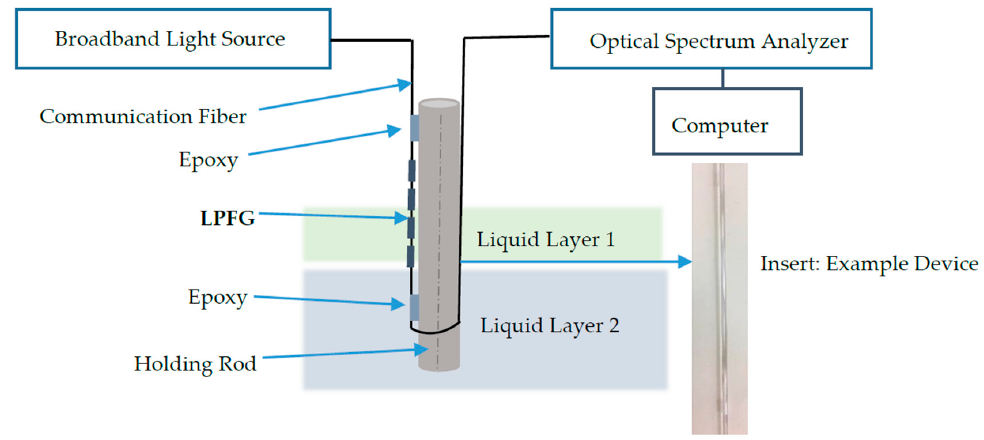
Figure 2. Schematic of the sensor device.